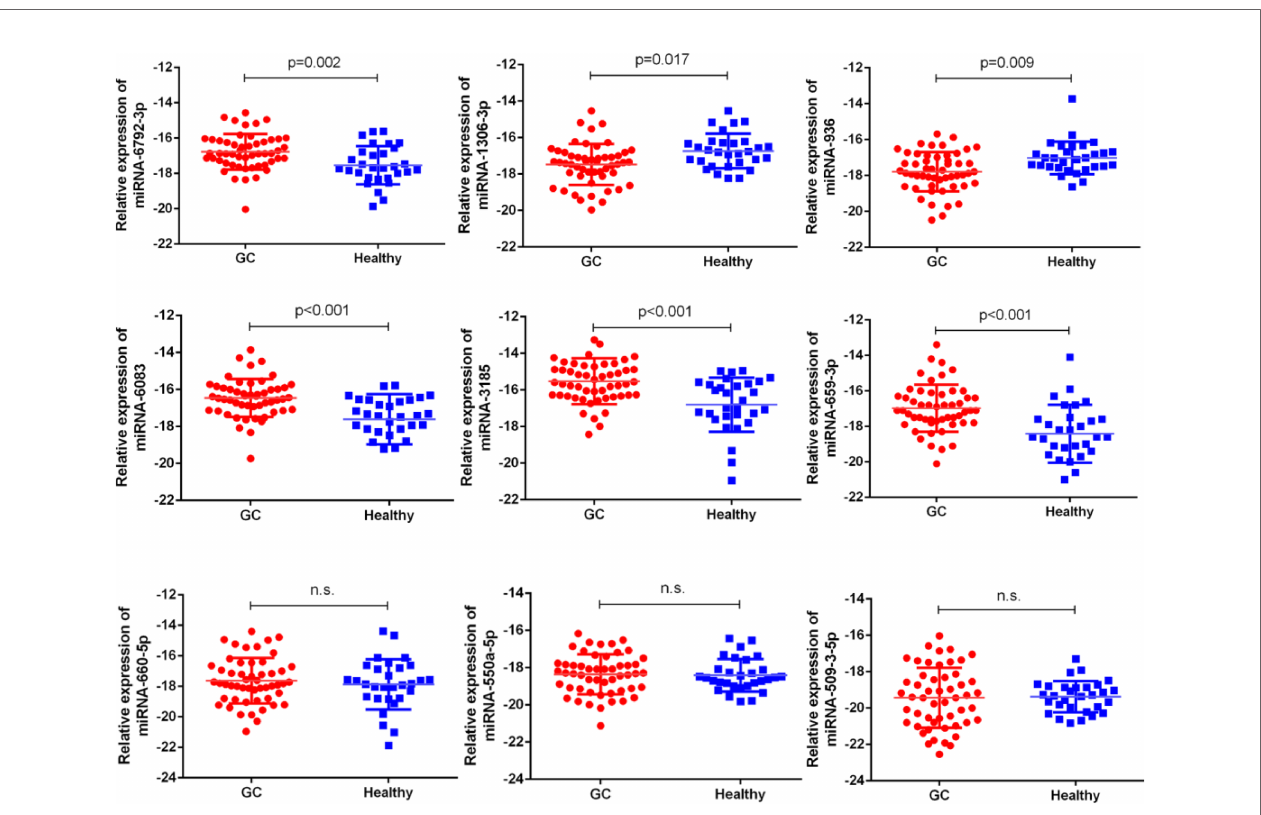
FIGURE 2 | The expressions of nine miRNAs in GC bloods compared to healthy controls. The correlation of their - D Ct value was determined. n.s., no signi fi